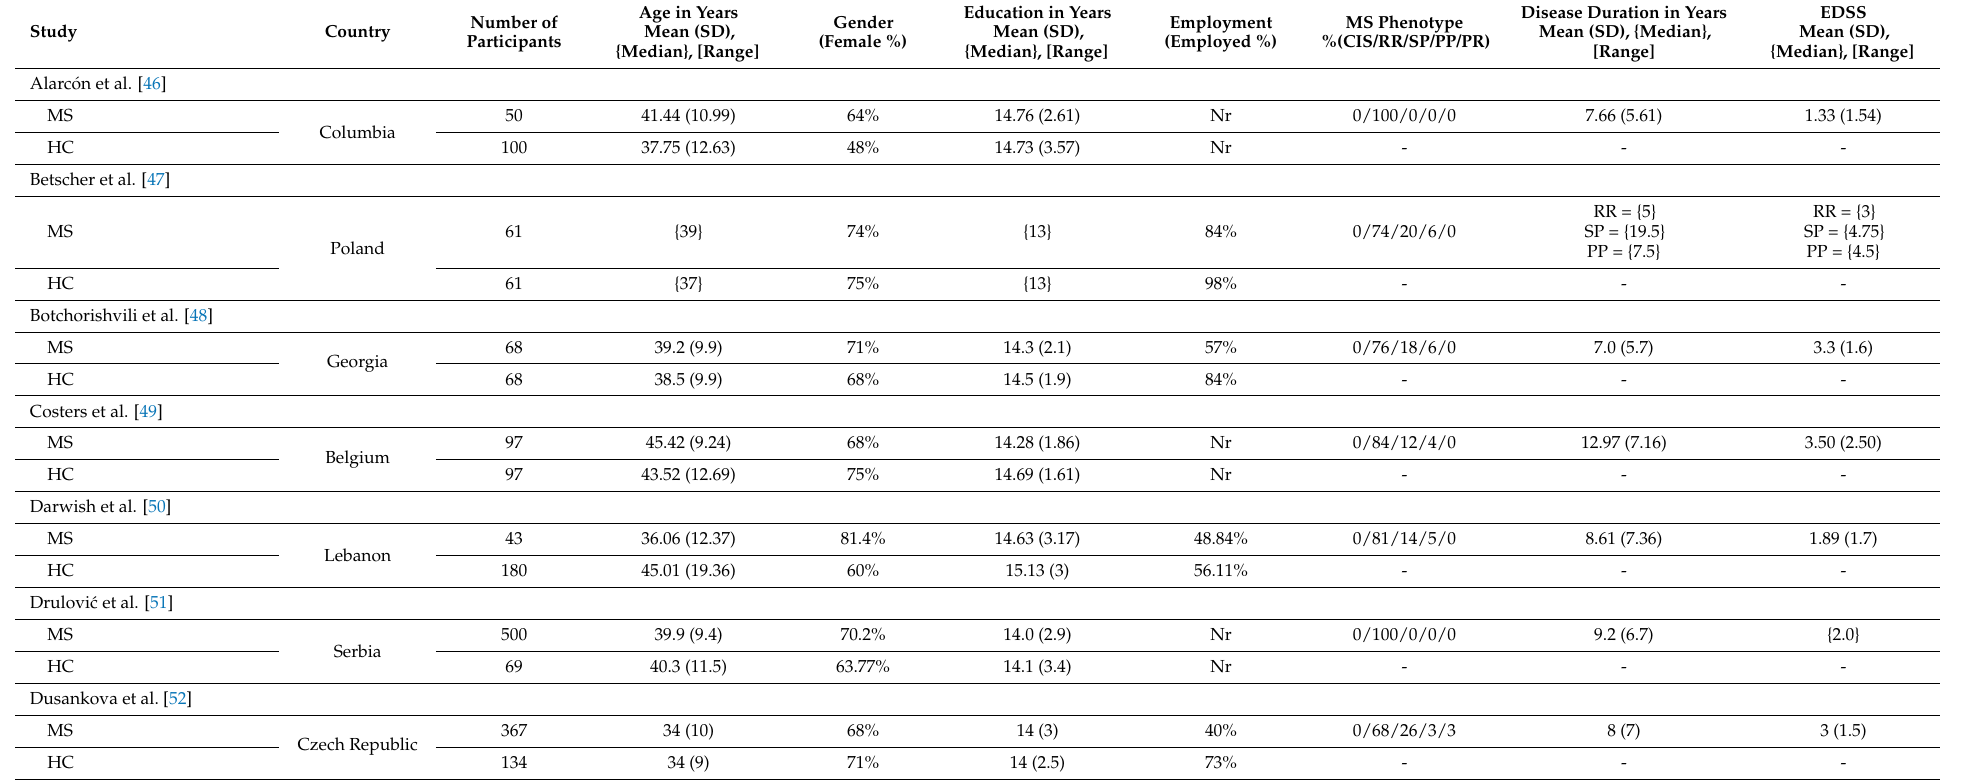
Table 2. Study characteristics and sample demographic and patient disease